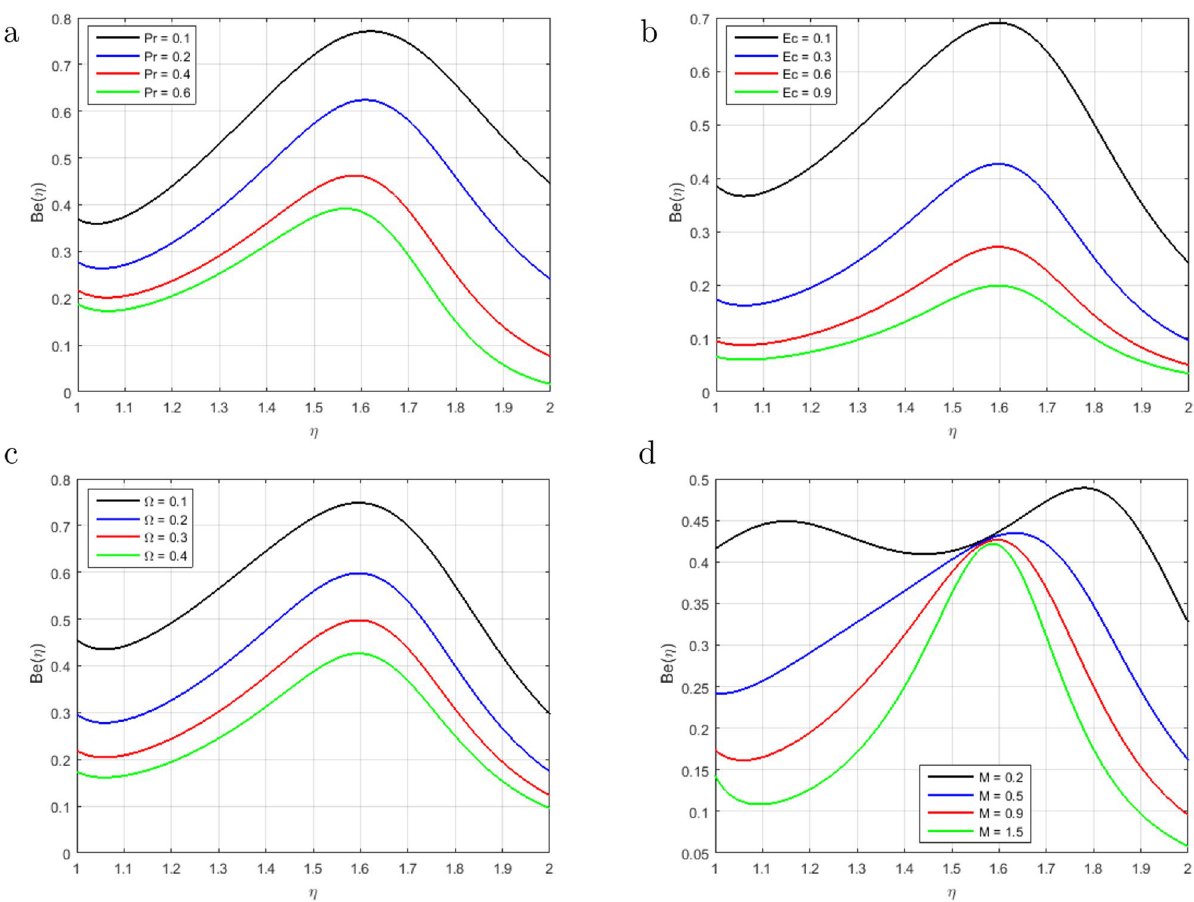
Figure 14. Influence of Be (η) for Pr , Ec , (cid:31) and M and fixed values of S = 3.3, Re m = 1.7, C 1 = 1.6, Hs = 2.2, Sc = 0.9, Sr = 1.6, δ = 0.5